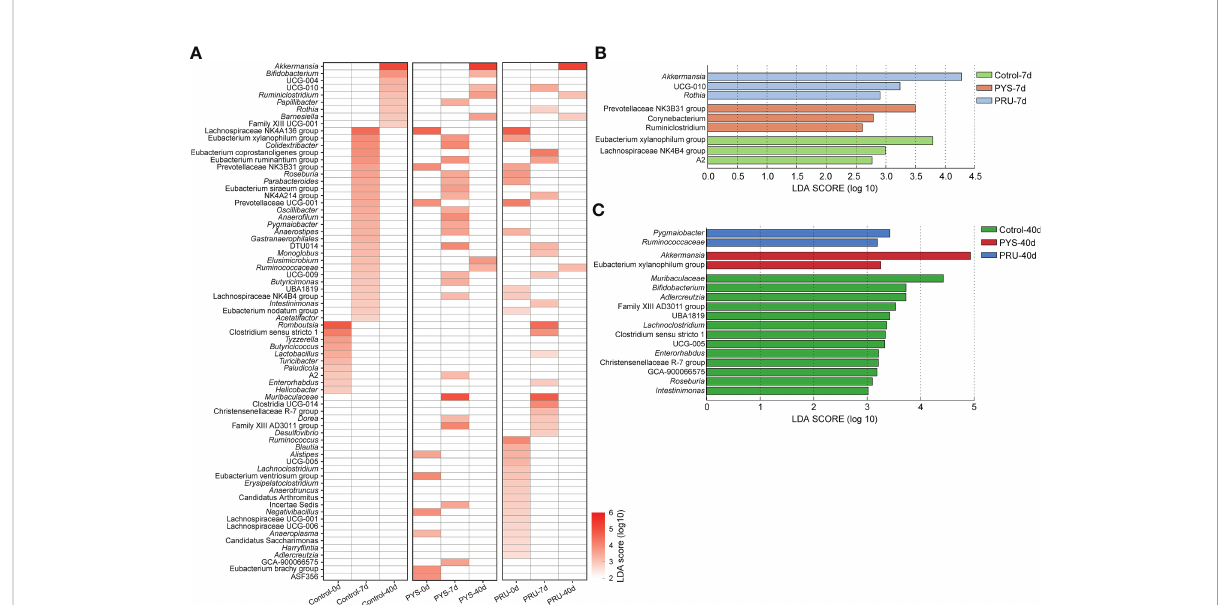
FIGURE 4 Lefse analysis of genus level. (A) The heat map is divided into three areas. Each area shows the different genera of control, PYS, and PRU groups in different infected periods. The red gradient represents the LDA score (log10) value. Blank means no signi fi cant difference or decline of the genus between groups. Brie fl y, blank means no signi fi cant difference when all three groups are blank, and enriched in one group means it is absent in the other two groups. (B) and (C) Differences at genus level between groups on day 7 and 40 post infection, respectively. The higher value of LDA Score (log10), the more signi fi cant difference is present between